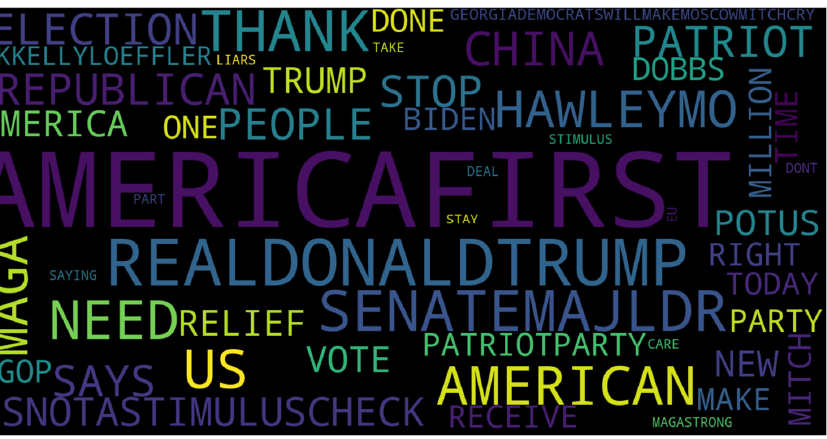
Figure 2. Word cloud depicts the most frequently occurring words in hate speech